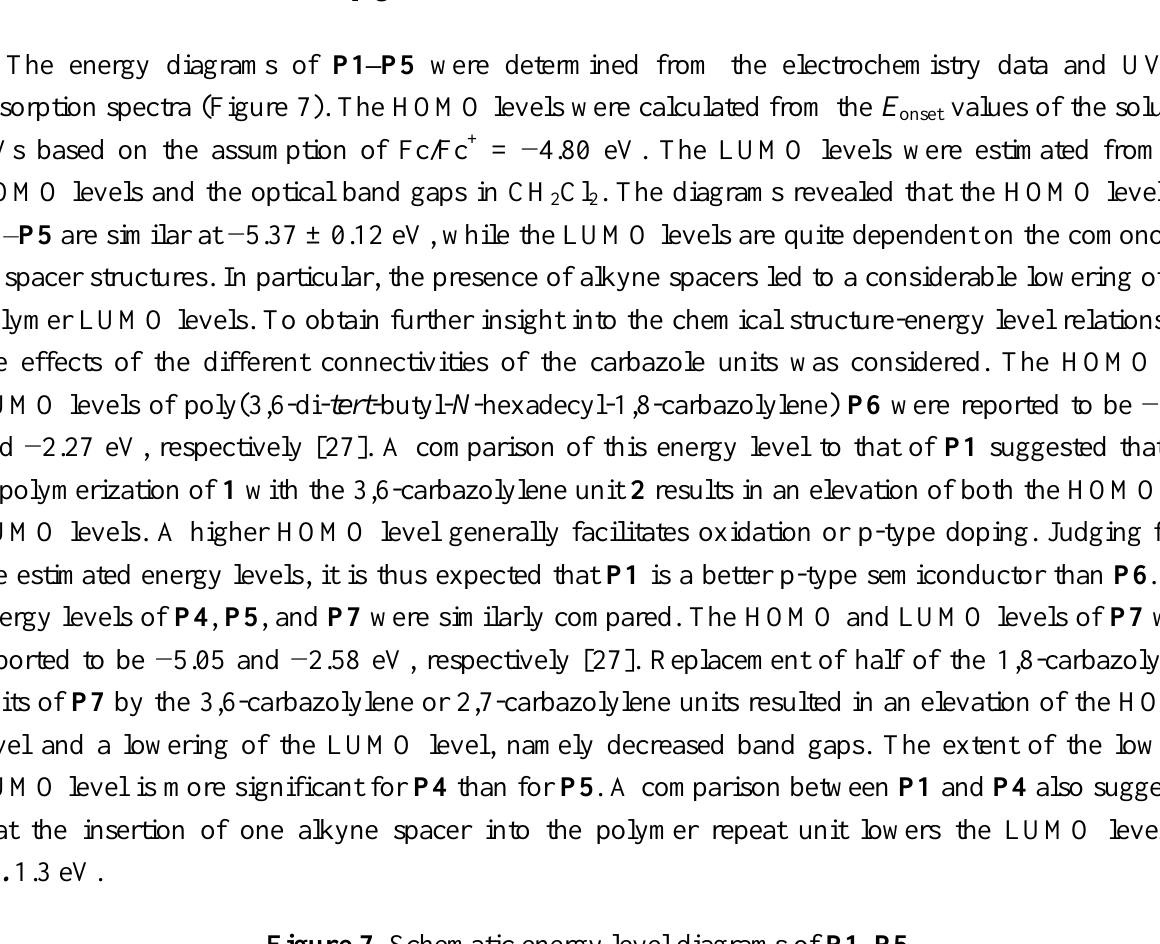
Figure 7. Schematic energy level diagrams of P1 – P5